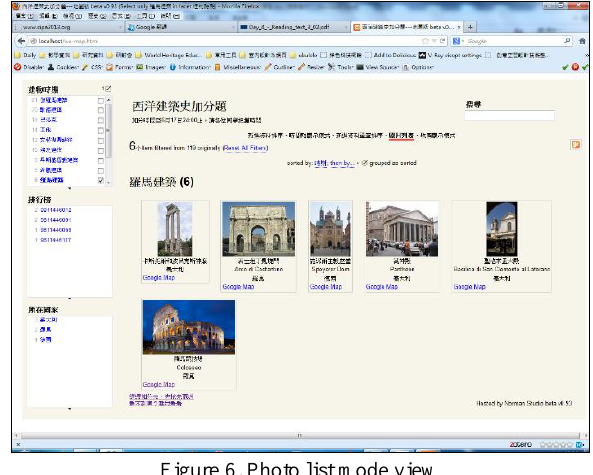
Figure 3. Google spreadsheets